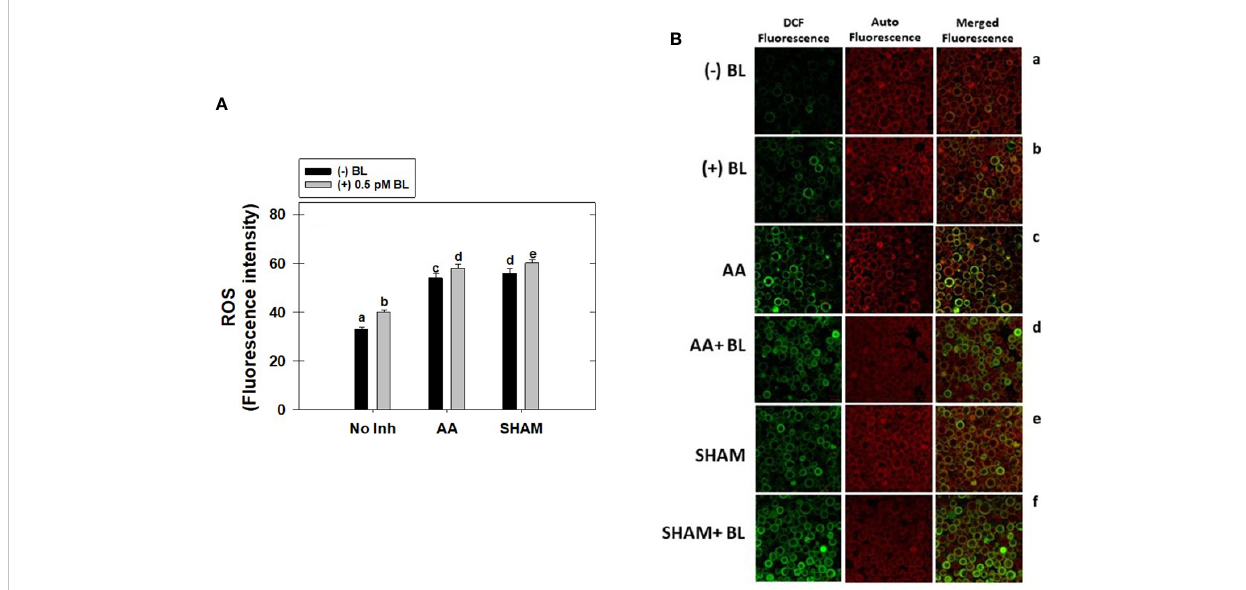
FIGURE 7 Effect of BL on total cellular ROS (A) and Confocal Microscopic images of ROS (B) under the disruption of COX pathway or AOX pathway in MCP of A . thaliana . The MCP in the reaction medium was pre-incubated with or without 0.5 pM BL in the presence or absence of 100nM AA (COX pathway Inhibitor) or 0.5 mM SHAM (AOX pathway inhibitor) for 10 min at a light intensity of 1000 m mol m -2 s -1 at 25°C. Further, the section “ materials and methods ” mentions more detailed information on the procedure. No Inhibitor (No Inh) depicts a sample without mETC inhibitors. A statistically signi fi cant difference is represented by different lowercase alphabetical letters (P ≤ 0.05) and values represent the average (± SE) of three